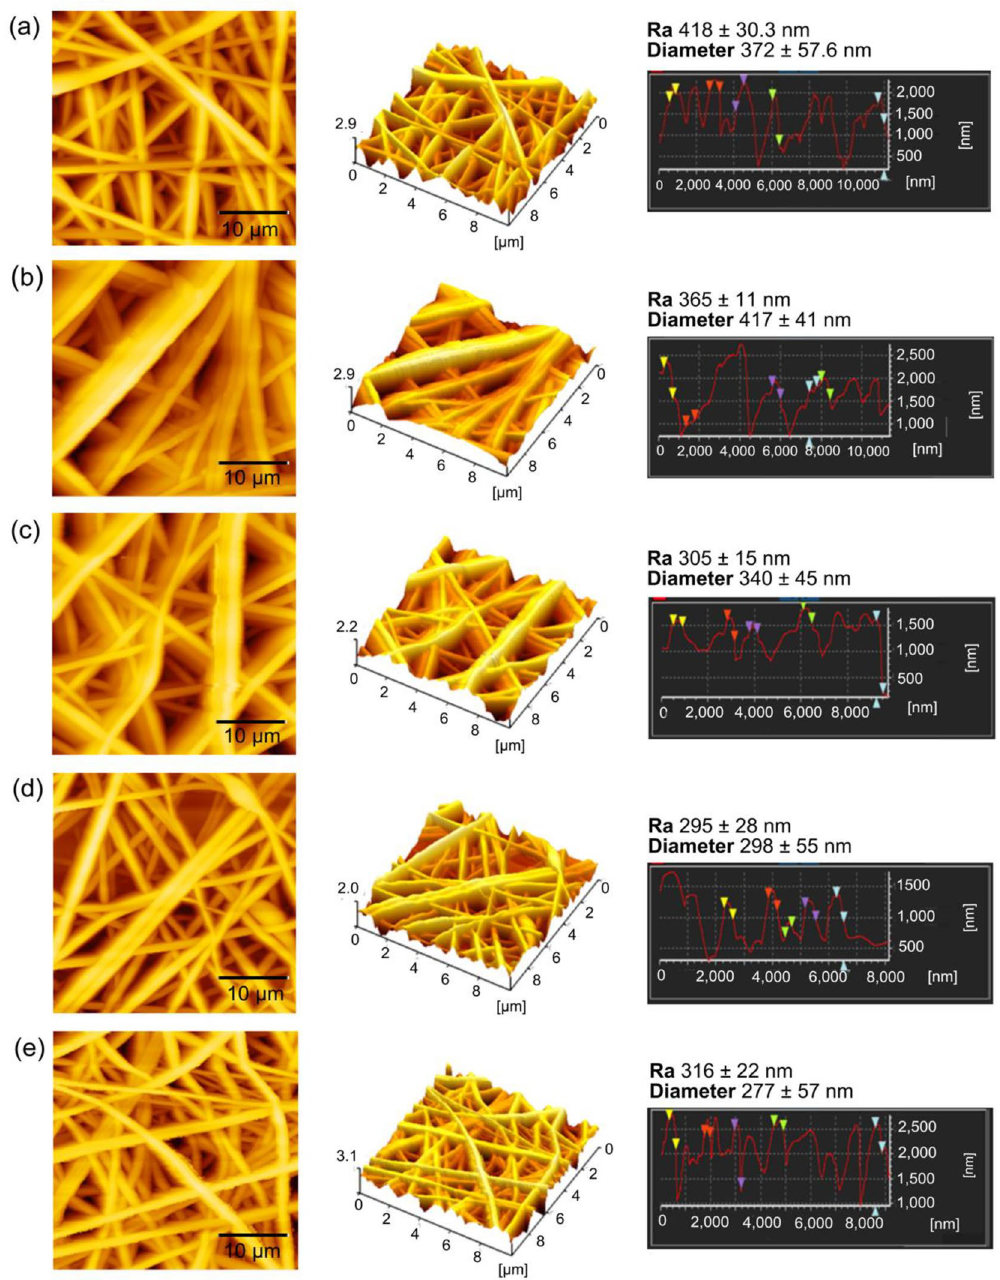
Figure 4. AFM topography images and surface roughness post-analysis of ( a ) PVA, ( b ) PVA/EGF, ( c ) PVA/ FGF, ( d ) PVA/EGF-FGF and ( e )